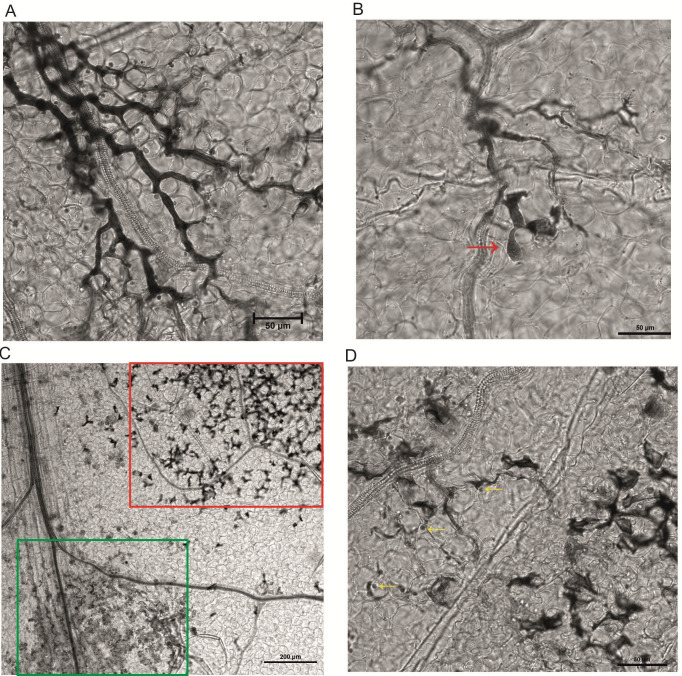
Trypan blue staining of A. thaliana leaves 15 days post infection with A. laibachii.(A) and (B) Control set with only A. laibachii (error bar 50 µm); (A) thick hyphal growth of A. laibachii on the leaf surface, and (B) appressoria formation can be seen (red arrow). (C) and (D) Treatment set (MbA sprayed 2 days before Albugo); (C): zoospores aggregated together, with few of them forming hyphae (green box); in addition, short, broken hyphae visualized in some regions (red box), which have not been found in control sets; (error bar 200 µm); (D): a closer look at the broken hyphae, yellow arrow indicates germinating cysts of A. laibachii (error bar 50 µm).